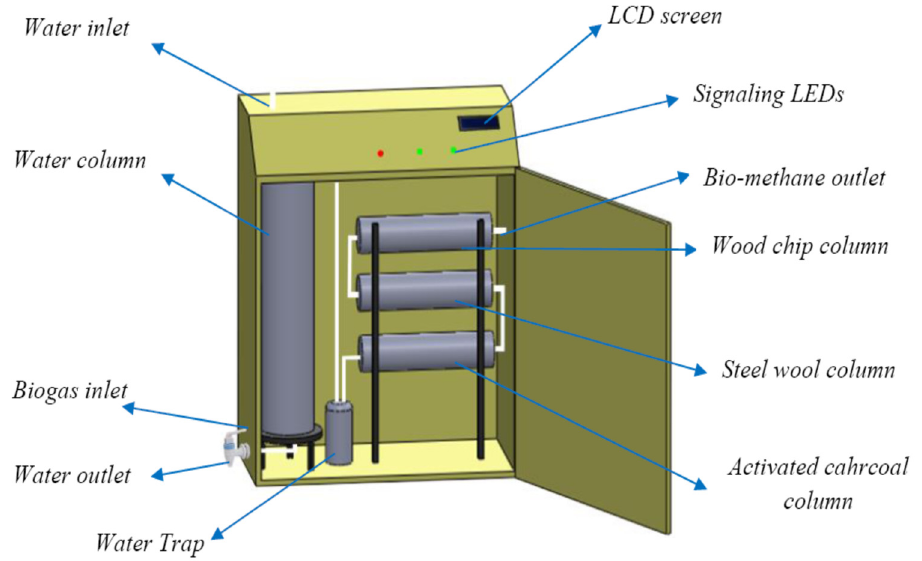
Figure 1. Complete diagram of the purification system.